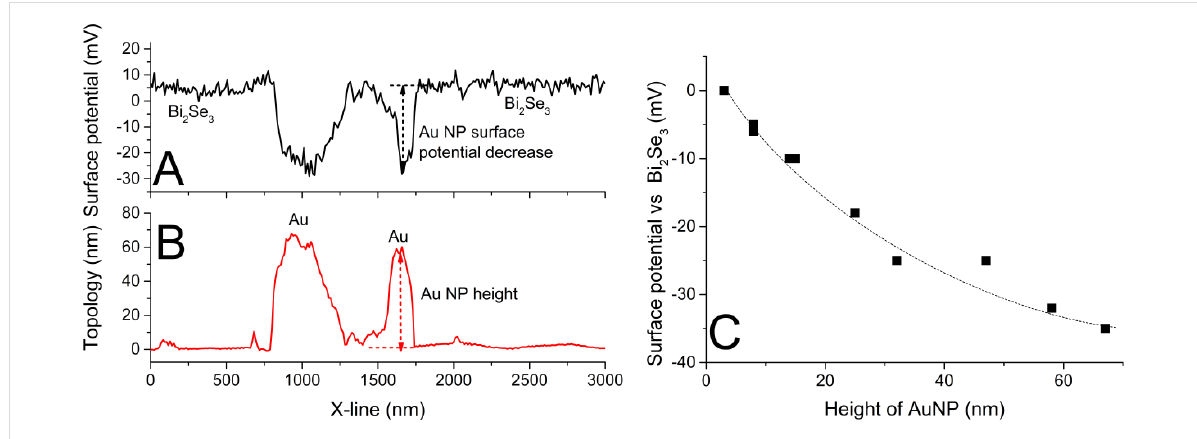
Figure 2: (A, B) Determination of the surface contact potential decrease and the height of the Au NPs; (C) surface contact potential as a function of the Au NP height.